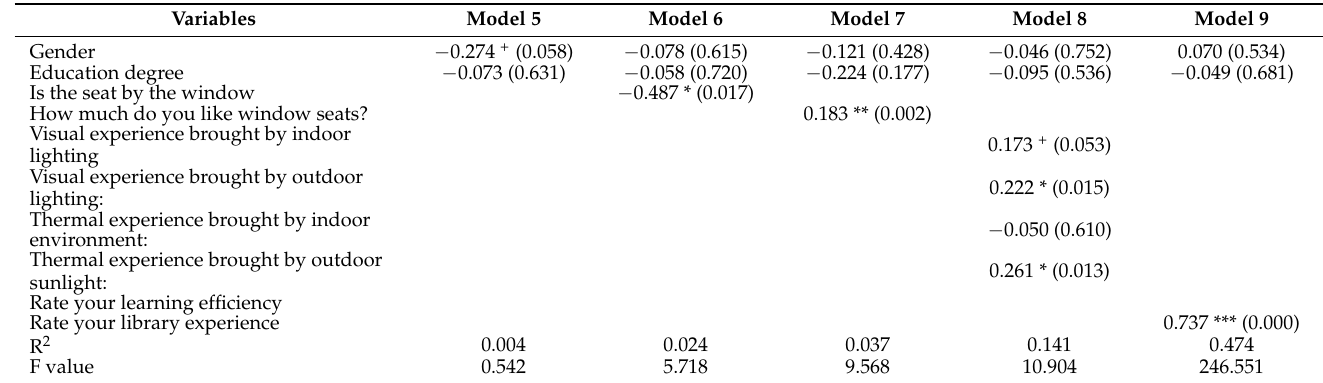
Table 2 contains Model 1 to Model 4 with “Learning experience” as the dependent variable. Model 1 was the baseline model, which explained 4.8% of the variance. Model 2 tested the behavior effect, namely, the relationship between Q1: “Is the seat by the window?” and “Learning experience”. Hypothesis 2a states that whether the seat consumed is by the window is positively associated with the learning experience of the consumer. In Model 2, we added the Q1: “Is the seat by the window?” variable to the equation and tested its relative contribution to the variance in the dependent variable. With respect to “Learning experience” in Model 1, Q1 increased the variance explained by 3.4%. The coefficient for